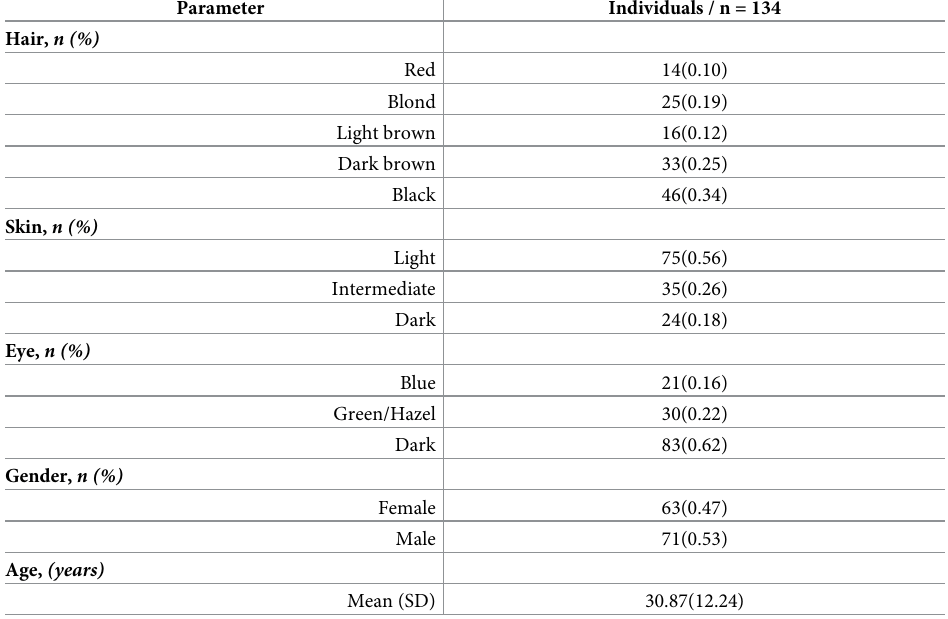
Table 1. Phenotypic frequency of admixed population from Rio de